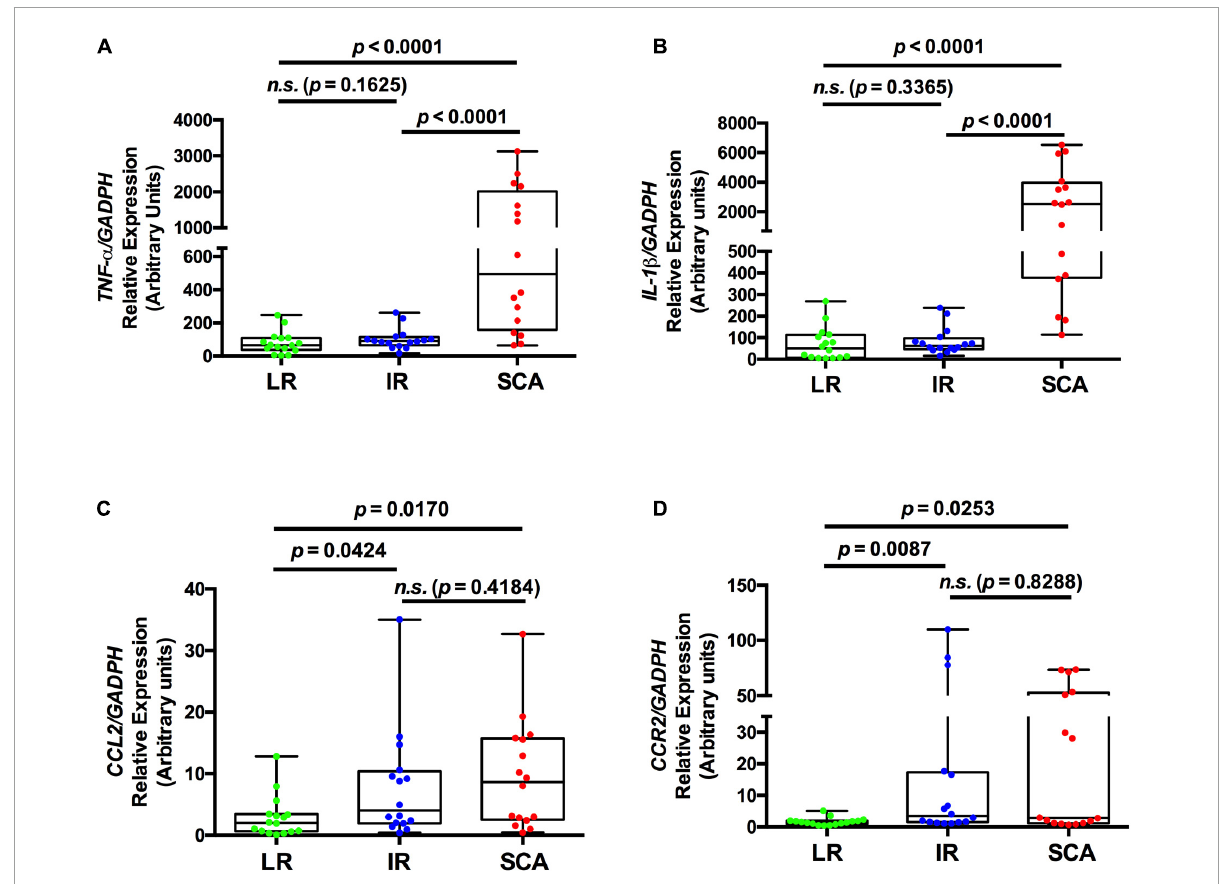
FIGURE2 Gene expression of pro-inflammatory factors is increased in circulating monocytes in SCA. The levels of specific transcripts of TNF- α (A) , IL-1 β (B) , CCL2 (C) , and CCR2 (D) were measured by quantitative RT-PCR (qPCR) in FACS-isolated total monocytes and relatively expressed at GAPDH levels from individuals with low risk (LR) (green symbols; n = 16), intermediate risk (IR) (blue symbols; n = 16) and subclinical atherosclerosis (SCA) (red symbols; n = 16) (Study II). Results are shown as box plot representing the median value and interquartile range (IQR) of arbitrary units for qPCR. Maximal and minimal values for each study group are indicated (bar lines). Parameters were log-transformed to achieve normal distribution and to apply statistical parametric analysis, but in these table the original data were used. p -values are shown and differences were considered statistically significant when p <